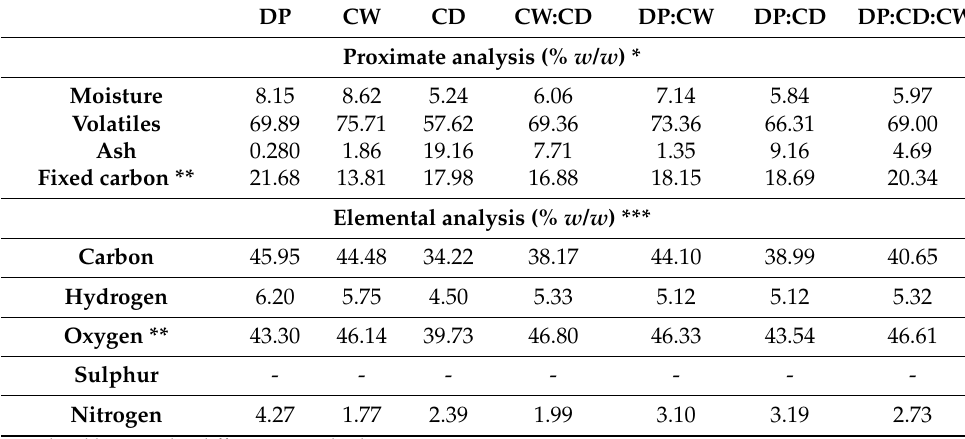
Table 1. Proximate and elemental analyses of studied biomasses.